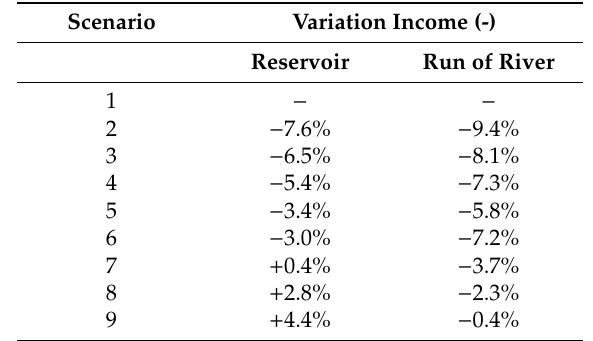
Table 6. Comparison of the income variation between run-of-the-river (RoR) and reservoir configuration in the case of climate scenarios at 2030 w.r.t. baseline climate scenario 1 over historical Italian electricity prices.